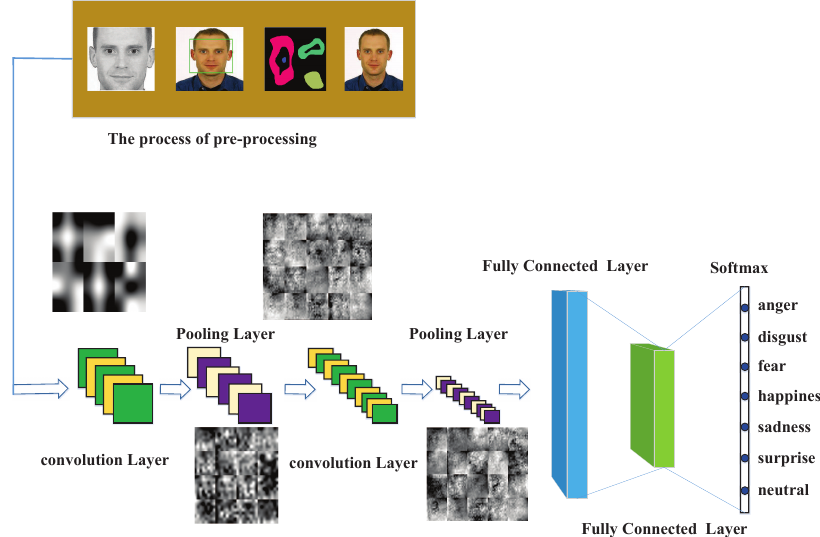
Figure 3. The structure of the common convolutional neural network. The convolutional neural network mainly includes convolution layer, pooling layer and full connection layer, and different layers have different functions. The convolution layer is responsible for feature extraction, the pooling layer is used for feature selection, and the full connection layer is used for